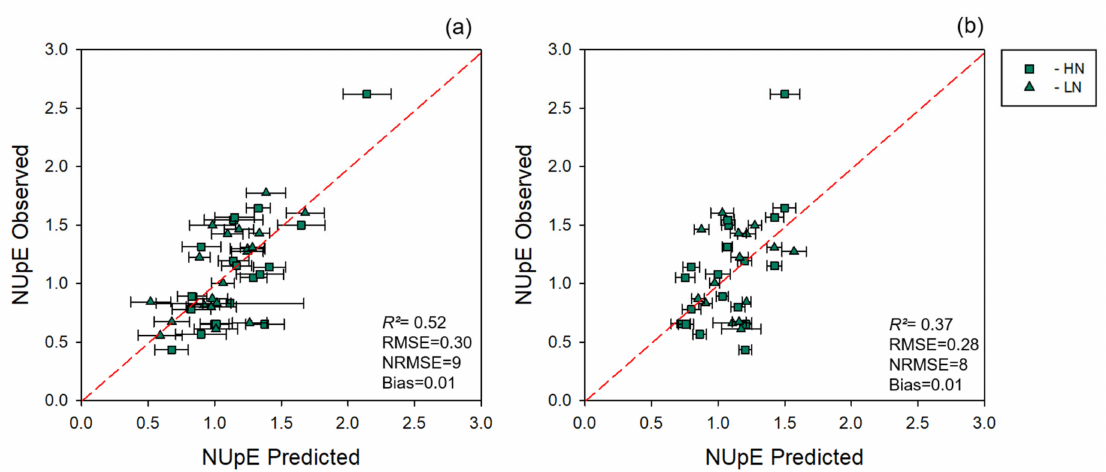
Figure 6. Observed vs. predicted values of NUpE estimated using spectral data. ( a ) Cross-validated NUpE estimates determined using leaf-level spectral measurements. ( b ) Cross-validated NUpE estimates determined using canopy-level spectral measurements. Error bars for estimated values represent the standard deviation generated from 500 model permutations using an 80:20 calibration:cross-validation approach. Dashed line: 1:1 relationship. R 2 : model goodness of fit; RMSE: root-mean-square error; NRMSE: normalized root-mean-square error.